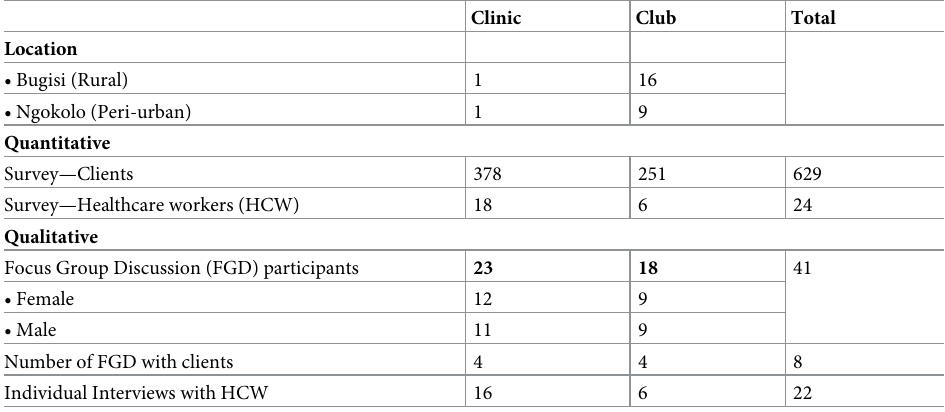
Table 1. Numbers of interviewed participants per location and data collection